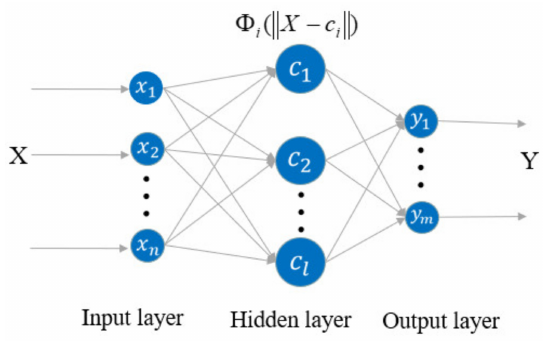
Figure 7. RBF neural network